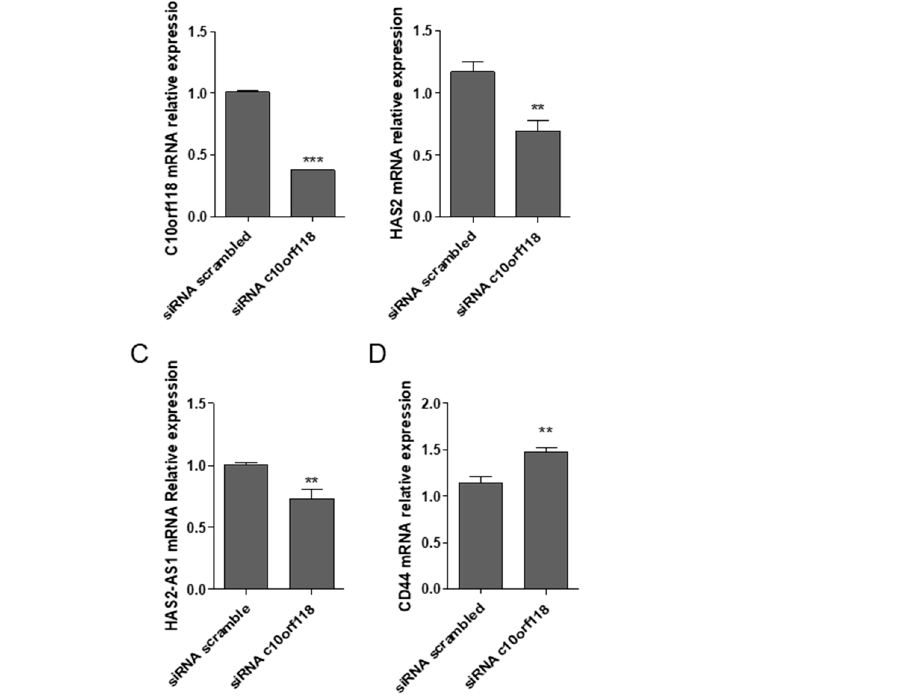
Figure 5. c10orf118 silencing influences HA-related genes expression in MCF-7. Quantitative RT-PCR analyses of MCF-7 cells nucleofected for 48 h with 30 pmol of c10orf118 siRNA or a scrambled siRNA. The graphs represent the mRNA levels of ( A ) c10orf118, ( B ) HAS2, ( C ) the long non-coding RNA HAS2-AS1 and ( D ) the HA receptor CD44. Data are represented as mean ± S.D. of six independent experiments. ** p < 0.01, and *** p < 0.001.